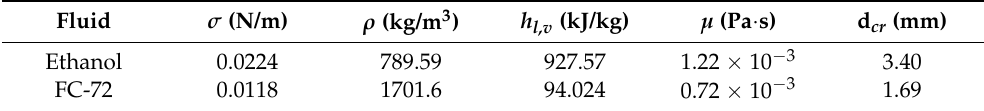
Table 2. Main properties of the two working fluids at 20 ◦ C.